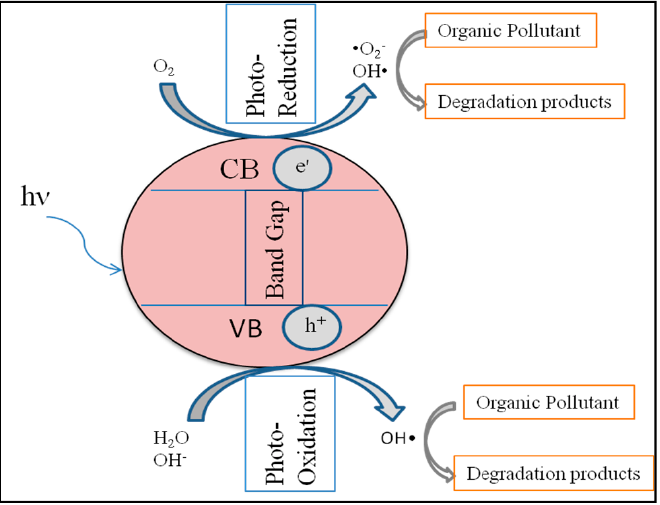
Figure 2. Principles of TiO 2 photocatalysis.